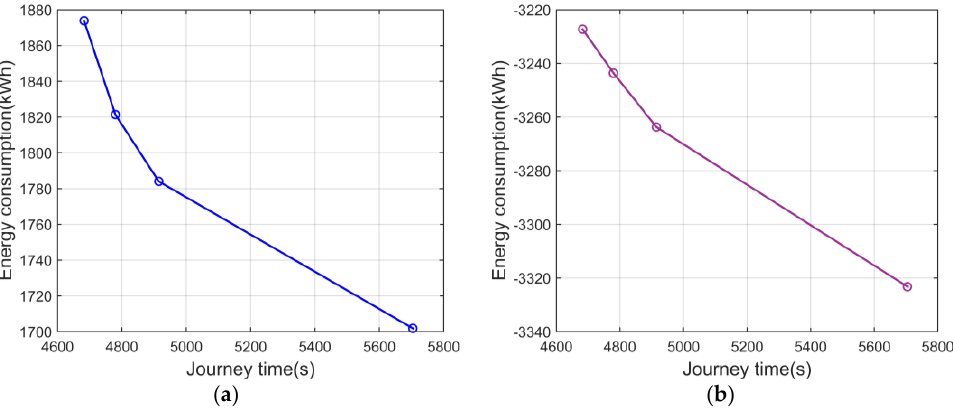
Figure 15. Relationship between energy consumption/total energy consumption and journey time: ( a ) Energy consumption and journey time; ( b ) total energy consumption and journey time.